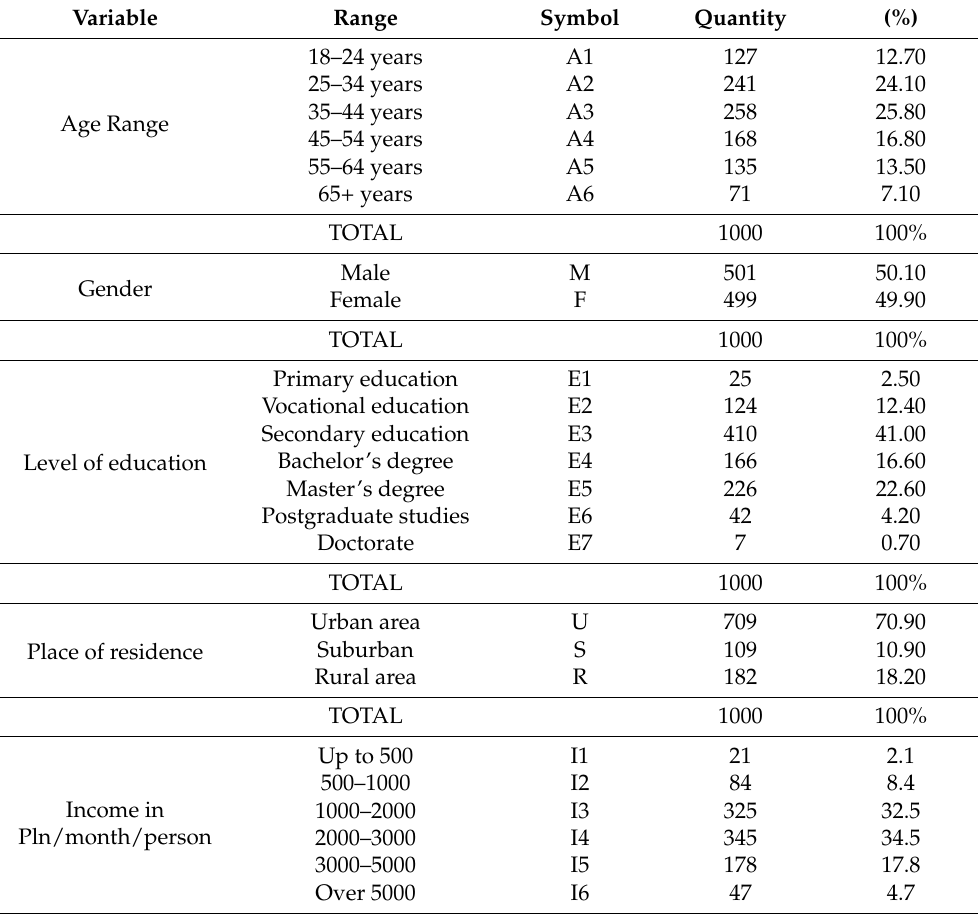
Table 1. Sociodemographic variables of the research